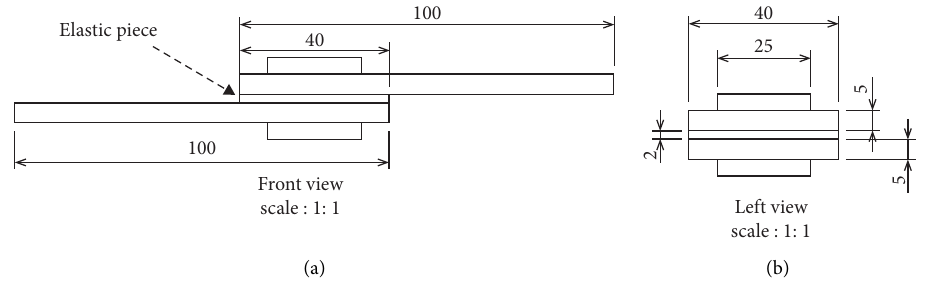
Figure 1: The overall drawing of the studied structure with elastic